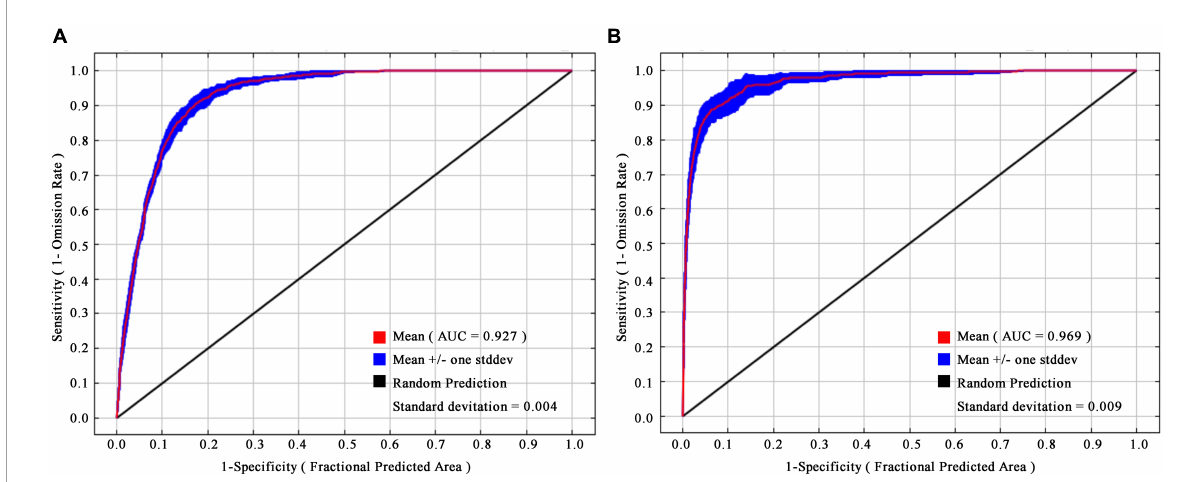
FIGURE2 Receiver operating characteristic (ROC) curves of (A) H.r. sinensis and (B) H. r. turkestanica .